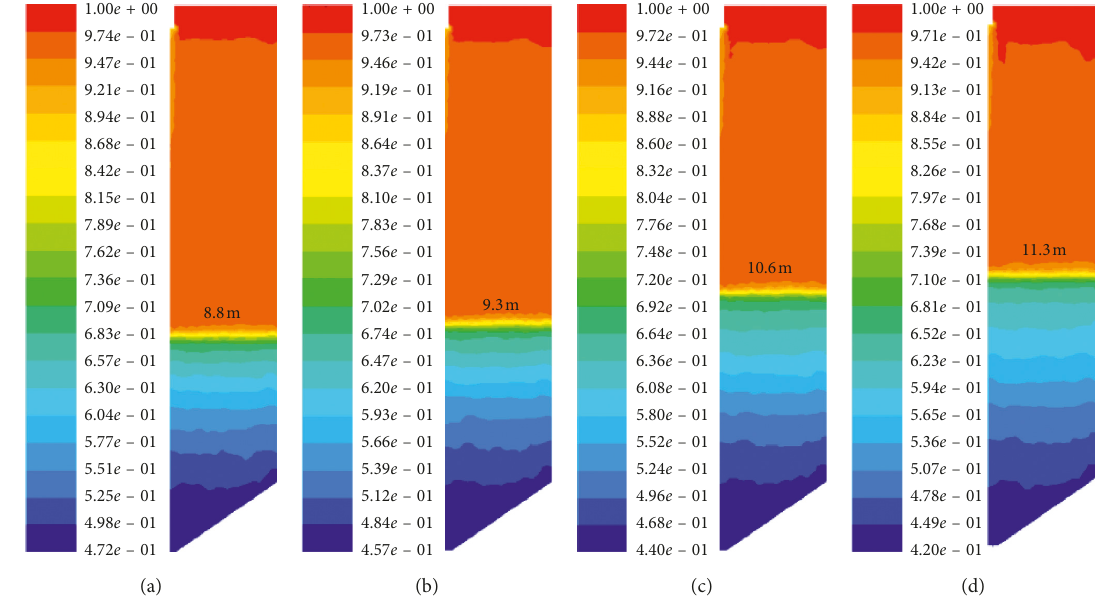
Figure 5: Volume fraction contours of the water phase, with interface levels of (a) 8.8 m, (b) 9.3 m, (c) 10.6m, and (d) 11.3m.